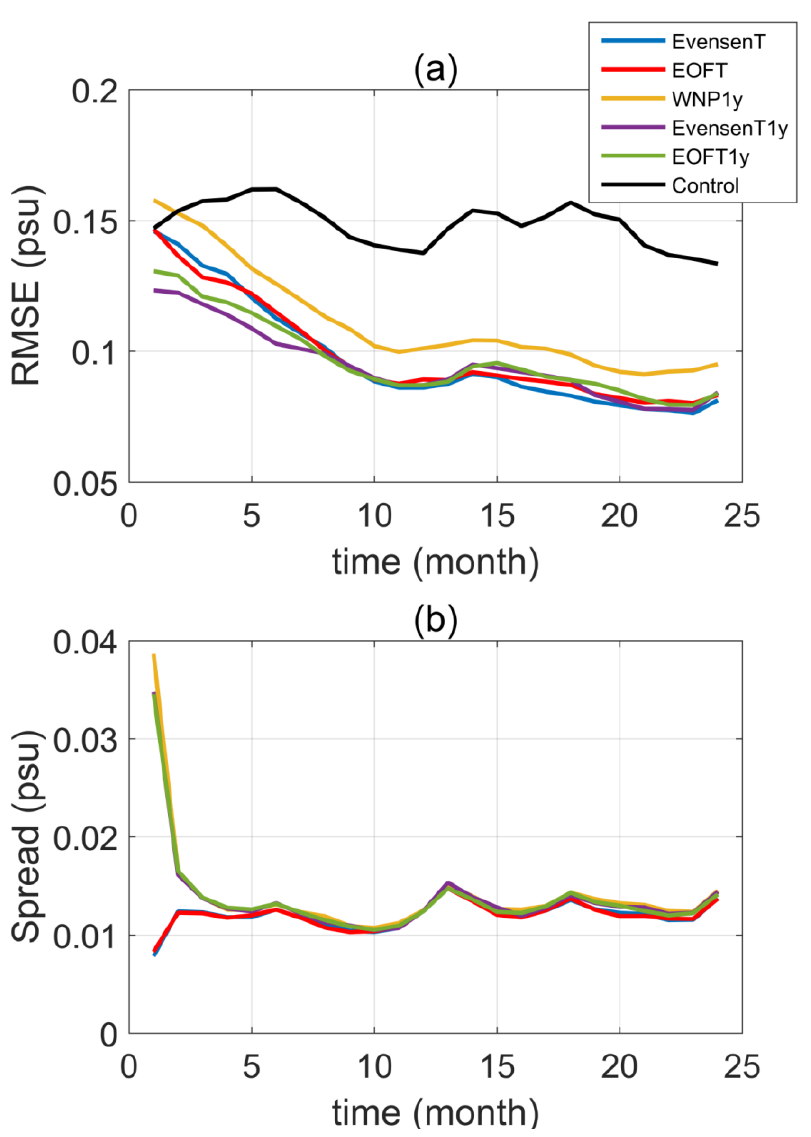
Figure 8 . Time series of RMSE (a) and spread (b) of the SSS compared with the true data for the six Figure 8. Time series of RMSE ( a ) and spread ( b ) of the SSS compared with the true data for the six experiments in region (70° S ~ 70° N, 180° E ~ 180° W) for a two-year period. experiments in region (70 ◦ S~70 ◦ N, 180 ◦ E~180 ◦ W) for a two-year